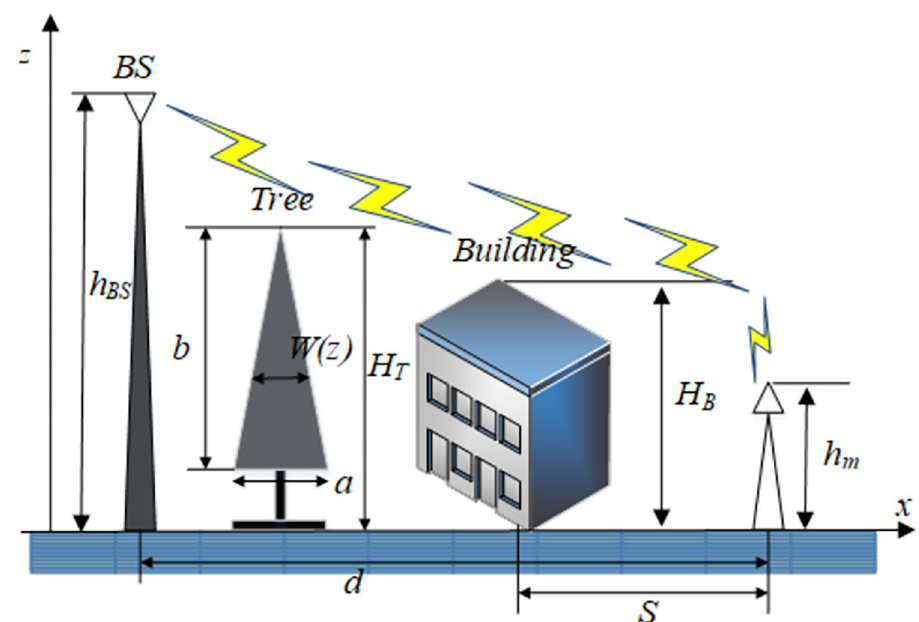
Fig 5. Diagram of triangular trees and